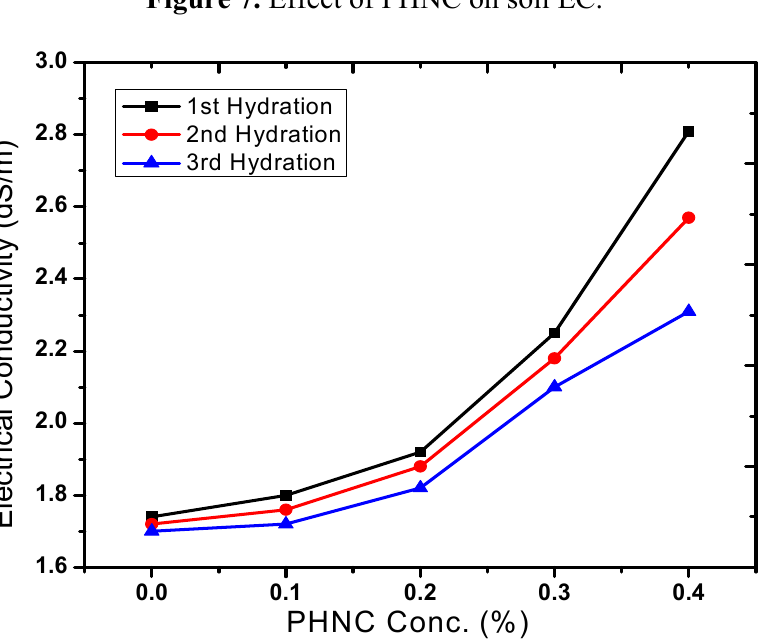
Figure 7. Effect of PHNC on soil